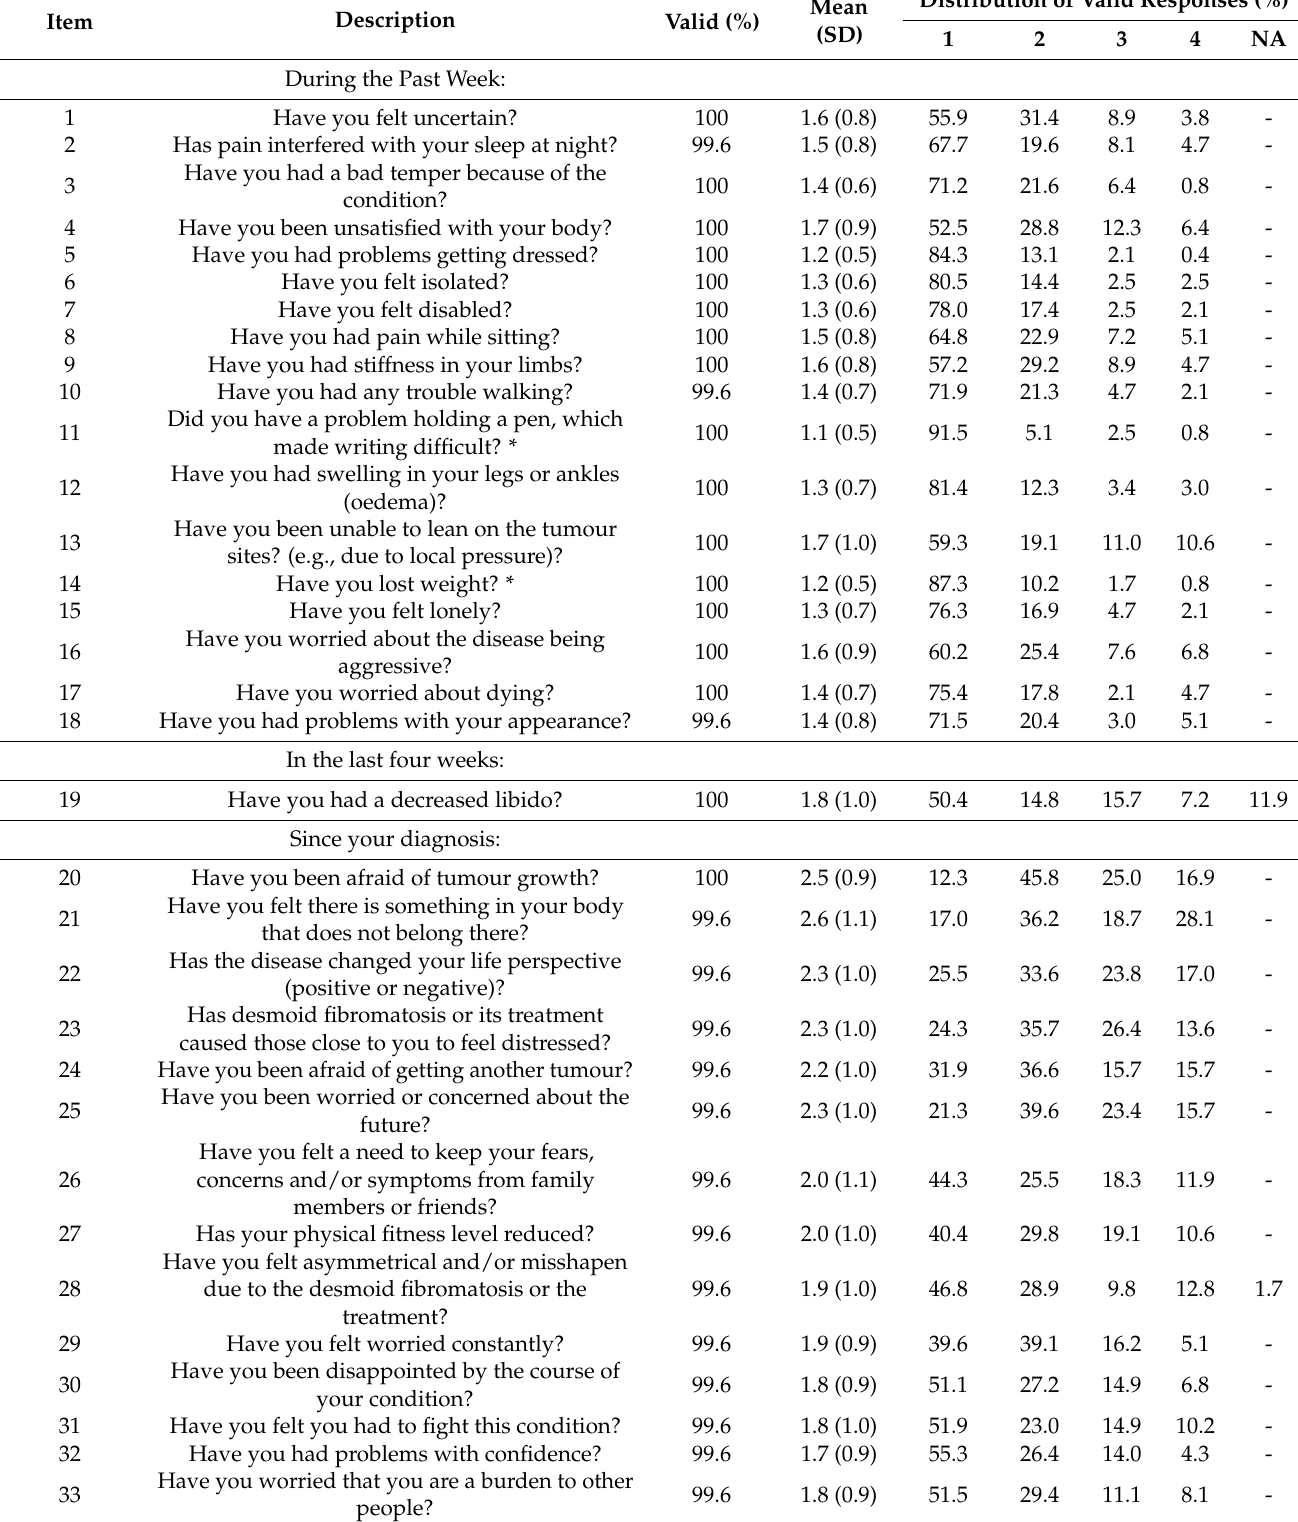
Table 2. Item descriptive statistics of 236 desmoid-type fibromatosis